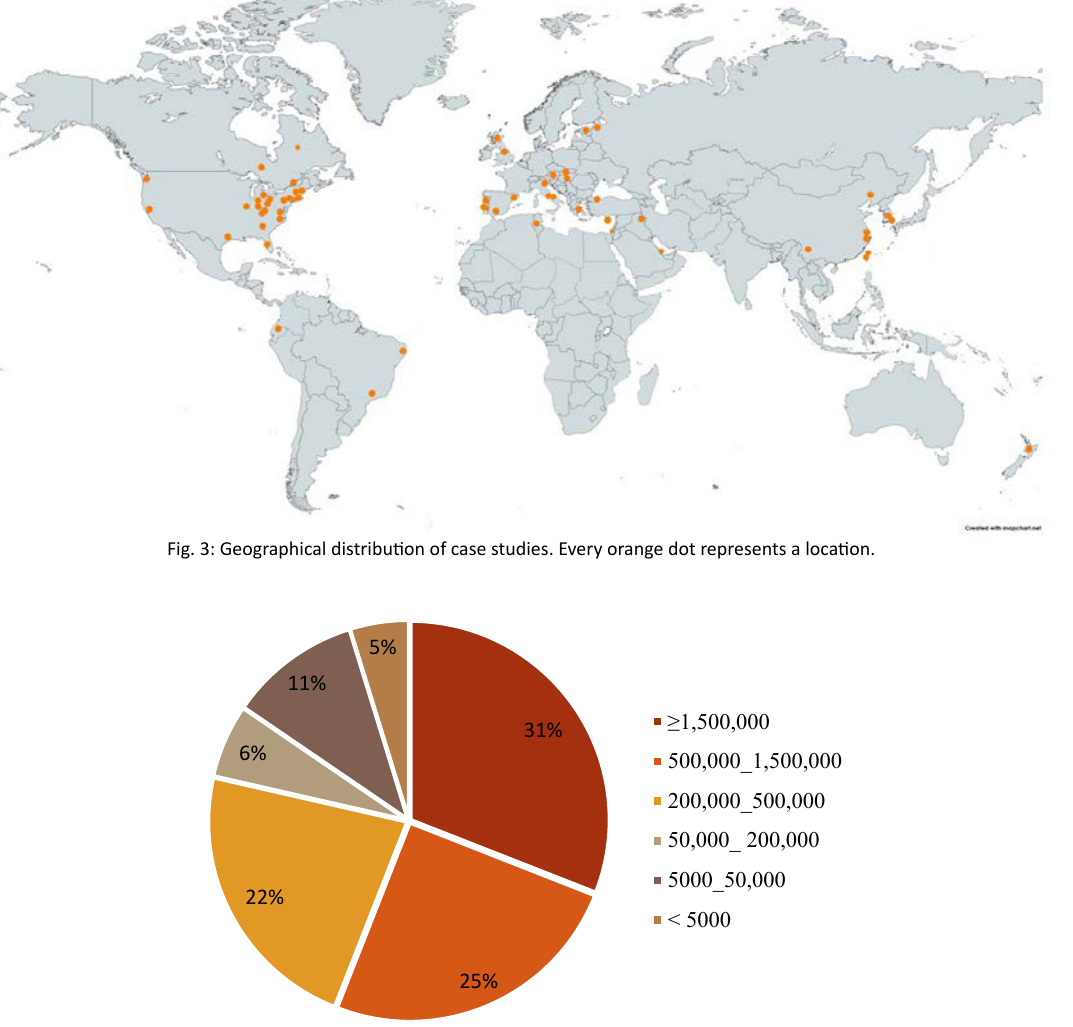
Fig. 4: Distribution of the publications concerning population statistics (Each case’s population was brought from the country’s national institute of statistics or United Nations data)